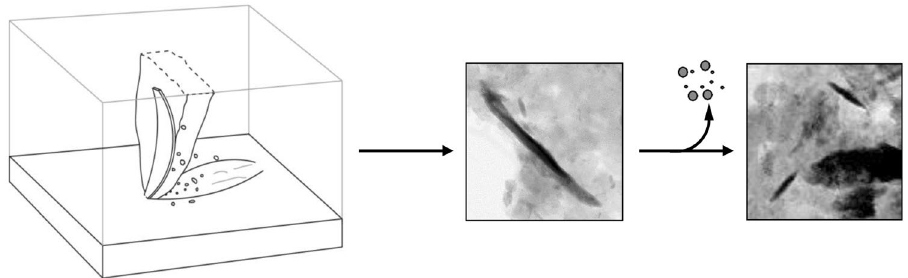
Figure 5. Schematic of an abraded acicular particle that is ground